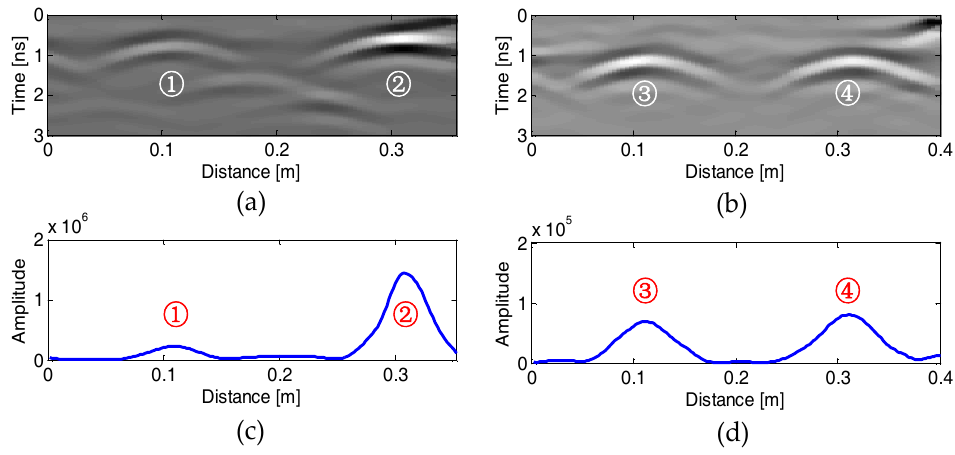
Figure 13. GPR profiles (upper) and EMI curves (lower) recorded over the first ( a , c ) and the second ( b , d ) columns in the field site. The serial numbers of the detected rebars are marked.